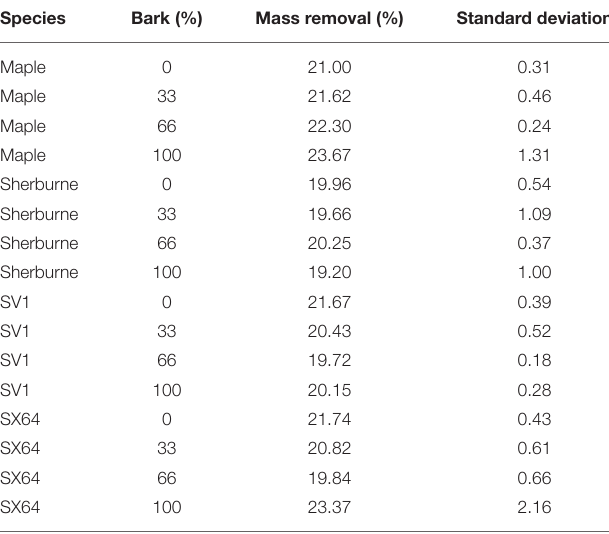
TABLE 1 | Mass removal following hot water extraction of sugar maple and three willow cultivars with different bark